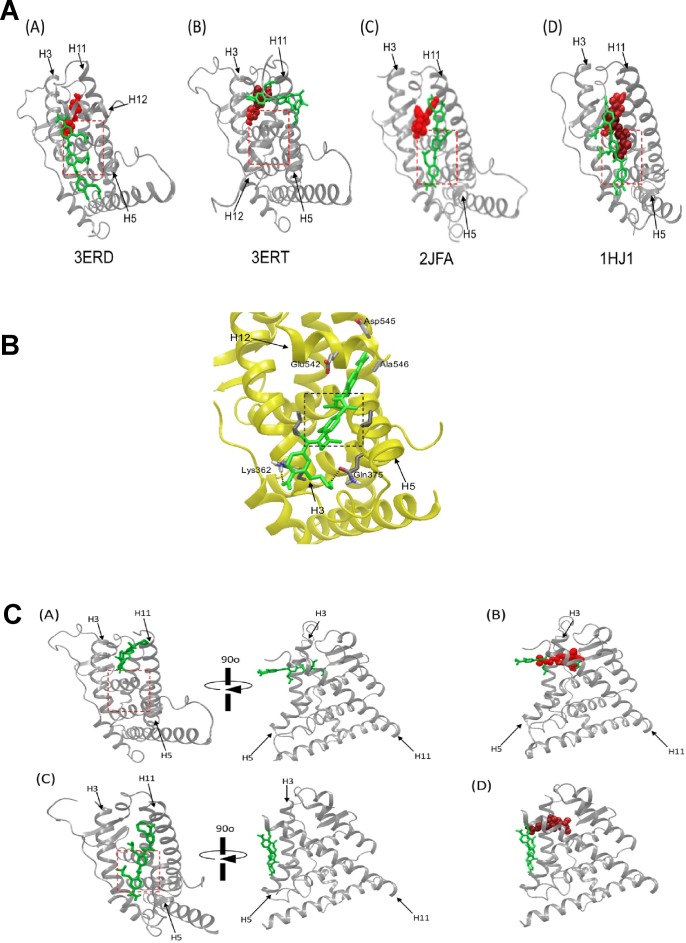
Models showing the putative interactions of ERX-11 with residues in the ER protein.(A) Docking studies of ERX-11 on different ER crystal structures shows that ERX-11 (green) can interact with ER, either in the presence of agonist diethylstilbesterol (red) (A: 3ERD.pdb), an antagonist, tamoxifen (red) (B: 3ERT.pdb), a corepressor peptide (red) (C: 2JFA.pdb) or a fulvestrant analog (ICI164,384) (red) (D:1HJ1). Importantly, tamoxifen displaces ERX-11 from its preferred binding site on ER to a secondary site. The AF2-binding pocket is outlined in the red dotted box. (B) Model showing the side chains and interactions of ERX-11 with residues in the ER protein using 1L2I.pdb structure. (C) Docking structure of ERX-11 on ER crystal structures of 3ERT and 5ACC with the deletion of the helix 12. (A) ERX-11 (green) binds to the tamoxifen-binding site, away from the AF2 domain (boxed in red). (B) Superimposition of ERX-11 (green) and tamoxifen (red) showing the overlap in their binding sites. (C) ERX-11 (green) still binds to the AF2 domain with the deletion of the helix 12 of 5ACC. (D) Superimposition of ERX-11 (green) and SERD (red) showing no overlap in their binding sites.